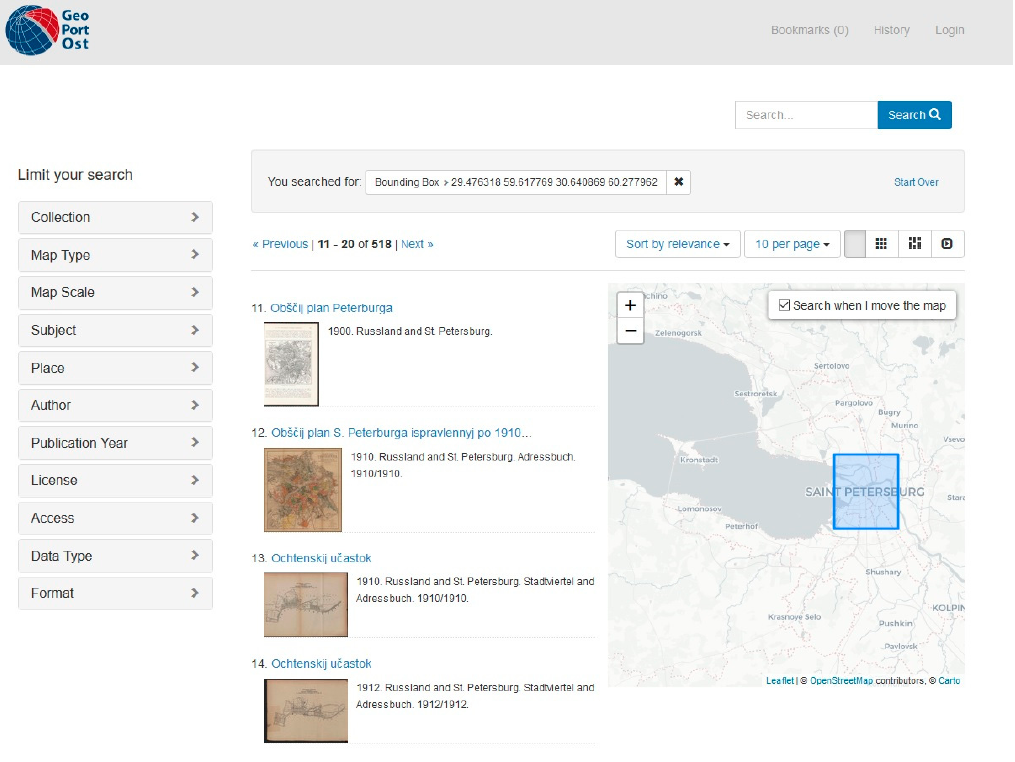
Figure 1. Geographic search in GeoPortOst.